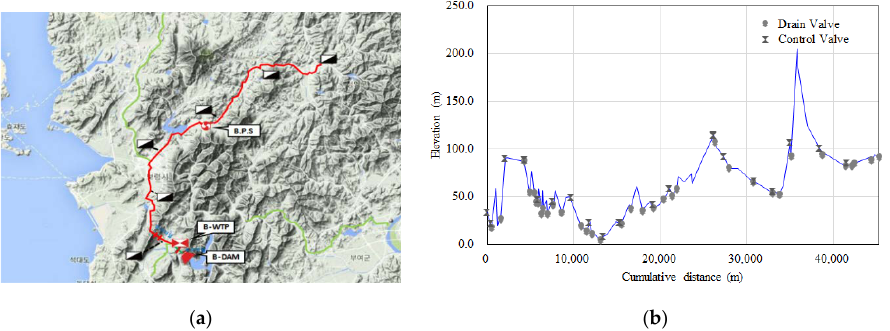
Figure 6. Schematic description of the CY transmission line in the BR water supply system: ( a ) plane view of the CY transmission line; ( b ) longitudinal profile of the CY transmission line.